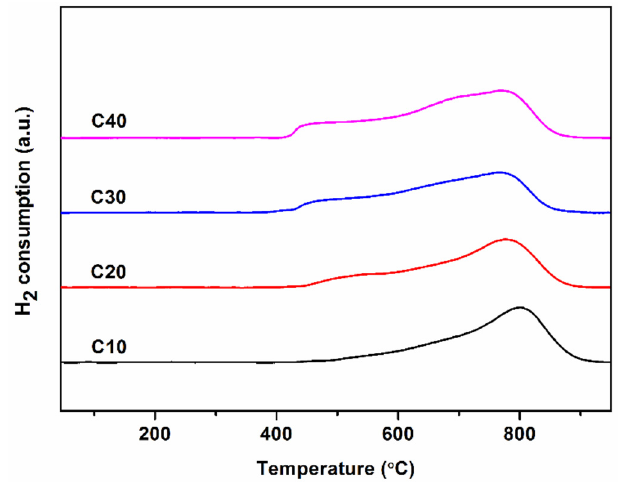
Figure 7. TPR profiles of the catalysts prepared with different metal ion contents. Table 3. Reducibility and Ni dispersion of Ni/Al 2 O 3 catalysts. Sample Peak Area